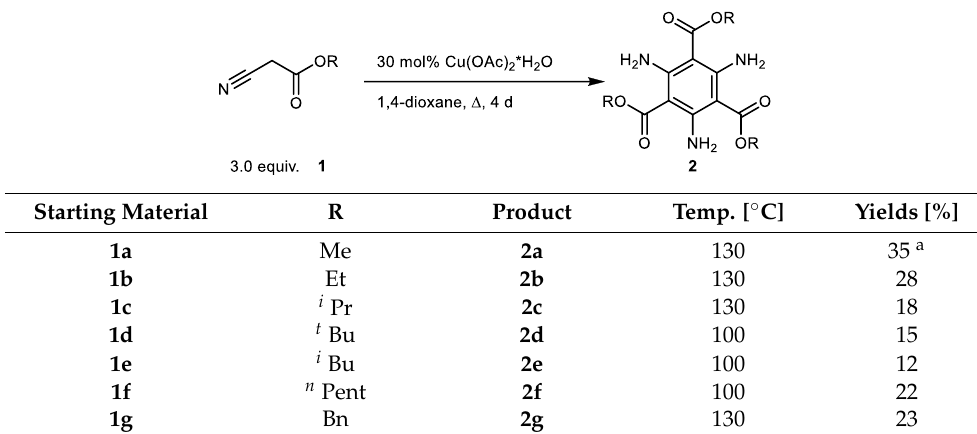
Table 1. Scope of the various alkyl triamino-benzene-tricarboxylates 2a – g . Table 1 . Scope of the various alkyl triamino-benzene-tricarboxylates 2a – g